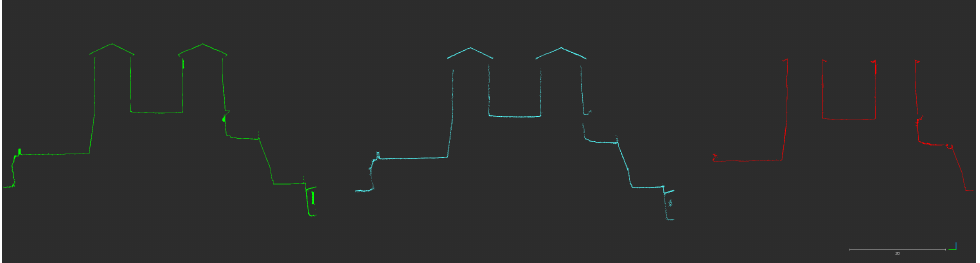
Figure 21. Extracted profile 2: P1 (green); L1 (cyan); SX10 (red). The registration and alignment of the second profile started from the P1 data (Figure 22).